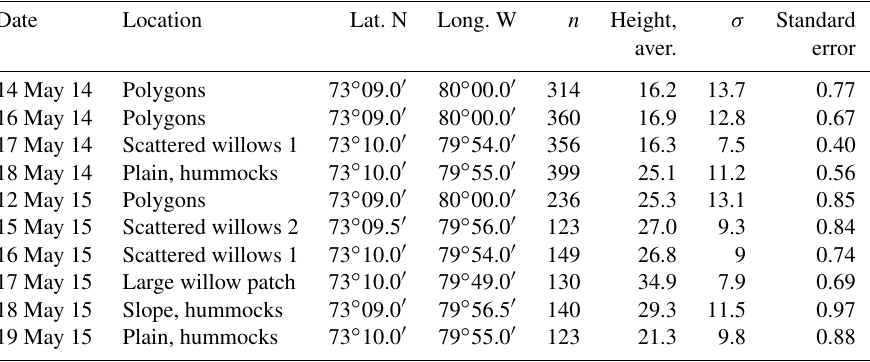
Table 1. Average, standard deviation σ and standard error ( = σ/n 1 / 2 ) of snowpack height (cm) in Qarlikturvik Valley, measured at several hundred spots around the coordinates indicated. Three sites were measured in May 2014 and 6 sites in May